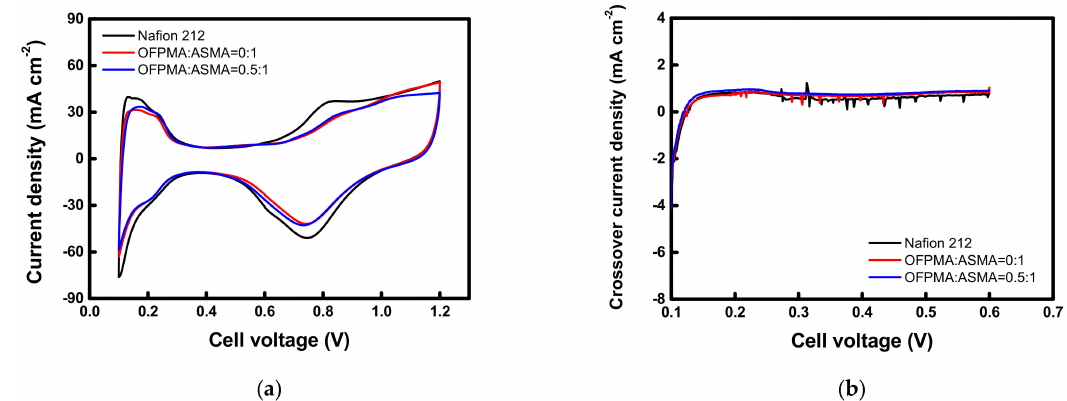
Figure 10. Electrochemical analyses of the MEAs employing a commercial membrane and prepared PFPEMs, respectively: ( a ) Cyclic voltammetry curves; ( b ) Crossover current density vs. cell